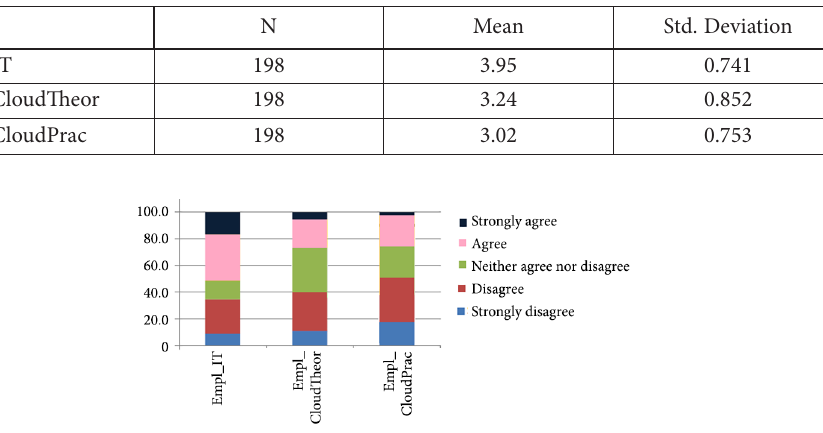
Table 4. Descriptive statistics for the variable employees’ know-how